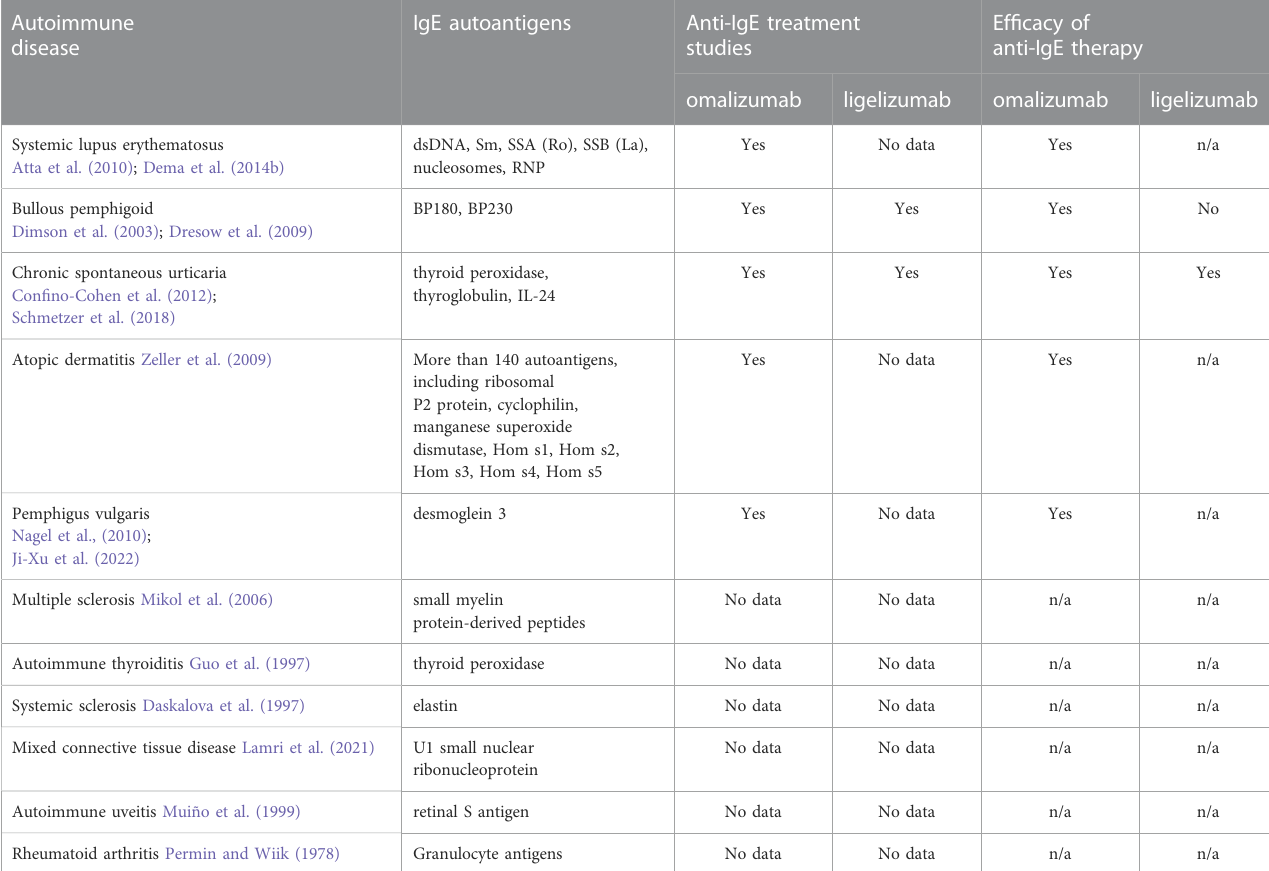
TABLE 1 A summary of autoimmune diaseases mediated by autoreactive IgE and the application of anti-IgE therapy. Autoimmune